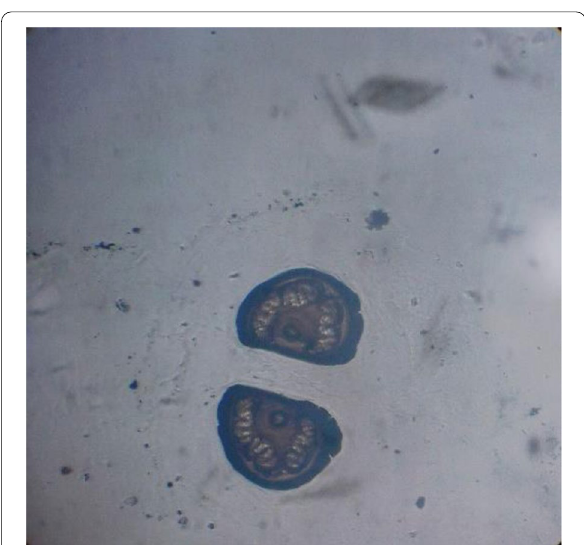
Fig. 4 Microscopic features of posterior spiracle of Musca domestica ( 100 Magnification). ‘D’-shaped posterior spiracle with “M” shaped × stigmal